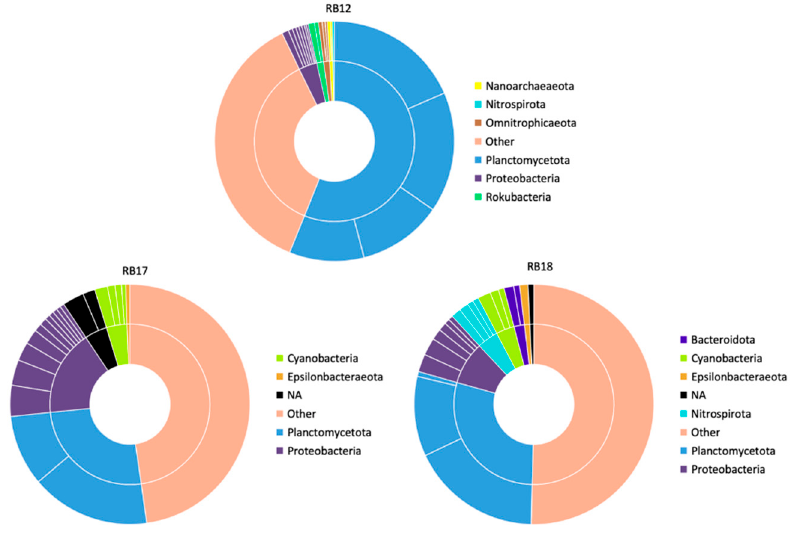
Figure 3. Sunburst chart of the top 50% or top 20 microorganisms (OTUs) with the highest abundance in the ammonia and nitrate contaminated bores (ANCBs) (RB12, RB17, RB18) separated by bore and organised by phylum. ‘Other’ represents the proportion of OTUs not represented by the top 50% of the most abundant OTUs. The inner ring of the sunburst chart represents the phylum taxonomic level and the inner ring represents the individual OTUs.